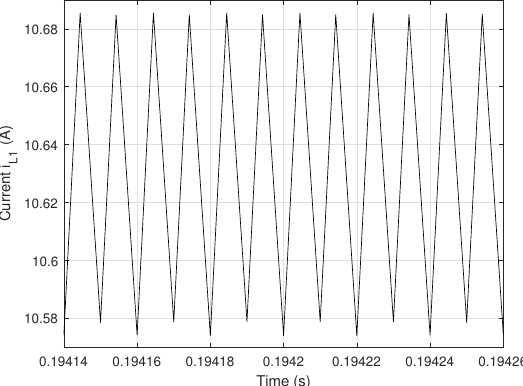
Figure 11. Time − domain waveform for R = 2 Ω in faulty switching case h 1 = h 2 = 1, h 3 = 0. Table 2. Eigenvalues of the monodromy matrix in faulty switching case h 3 = 0, h 1 = h 2 = 1, as R varies. R ( Ω